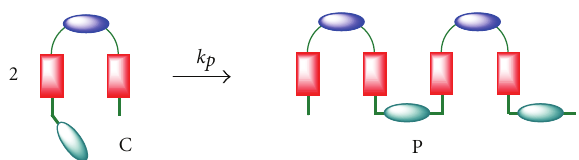
Scheme 5: Reaction scheme for kinetic model 4. Reaction of C with C to give P.